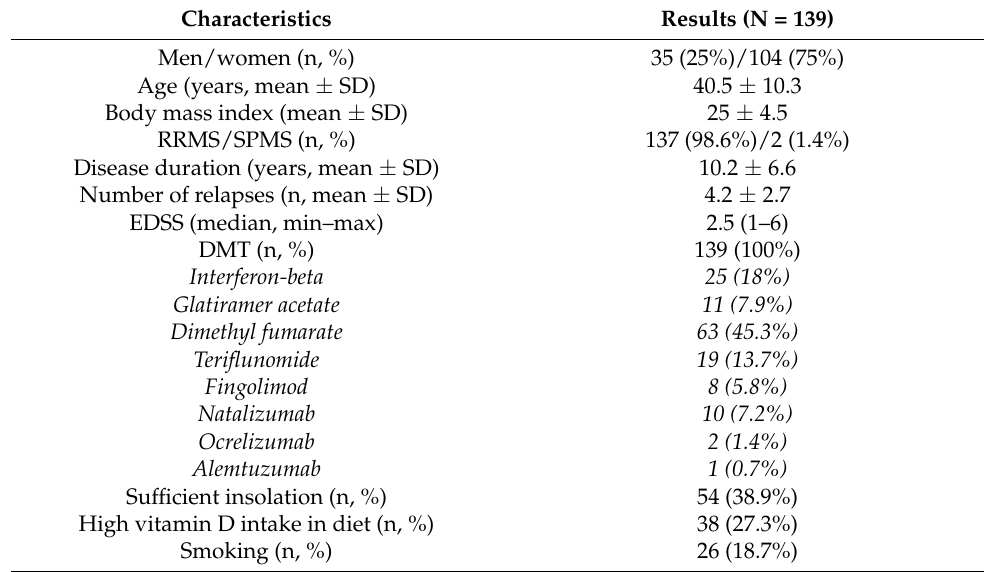
Table 1. Demographic and clinical characteristics of the study group.